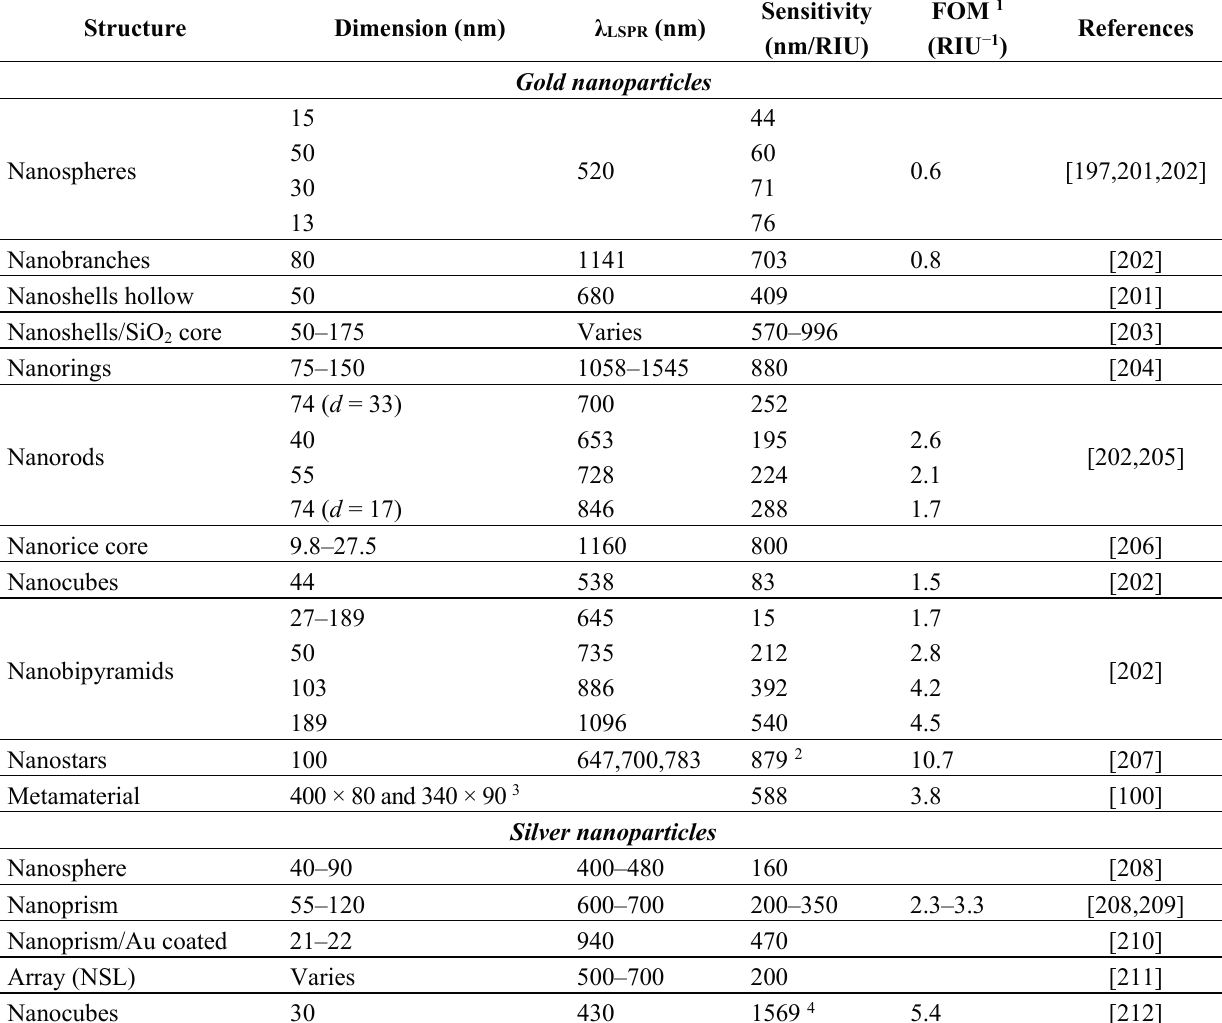
1 : Figure of Merit; 2 : Value converted from eV RIU − 1 to nm RIU − 1 ; 3 : H-fashioned cut-out structure in 30 nm gold film; 4 : Value transformed from the unit of eV RIU -1 to nm RIU − 1